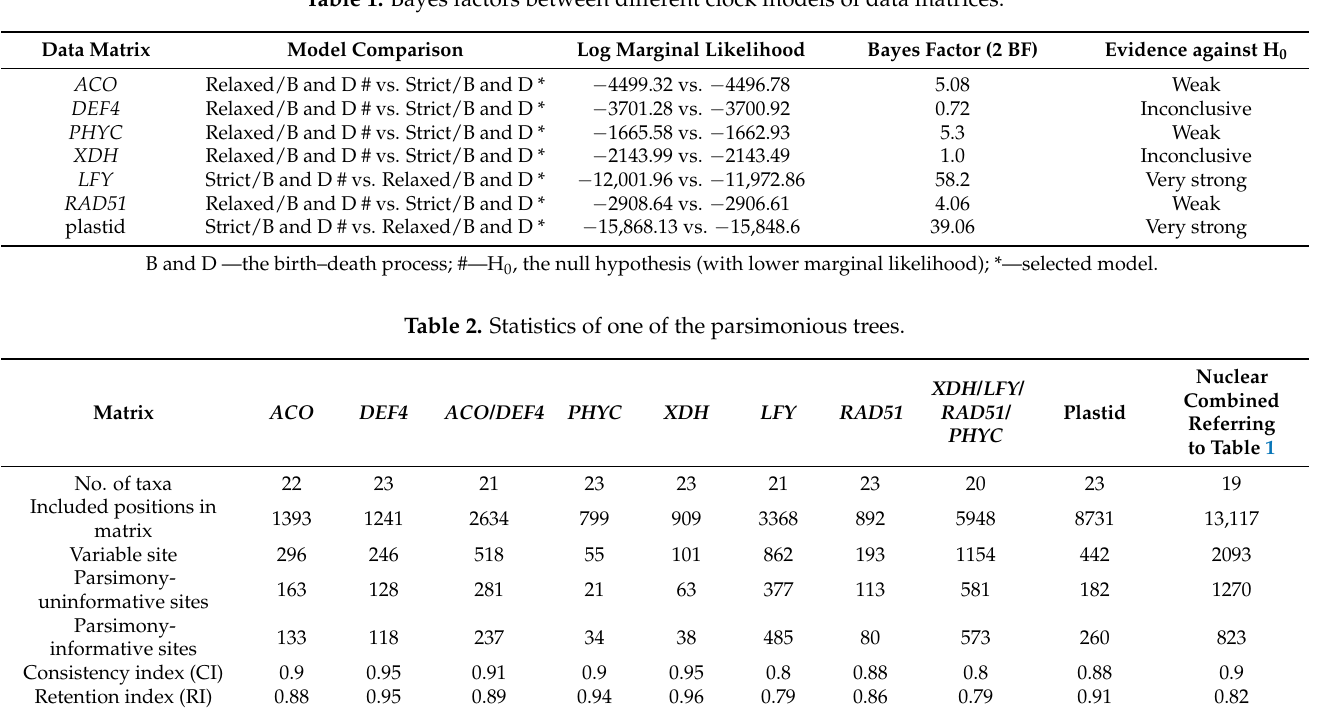
Table 1. Bayes factors between different clock models of data matrices.